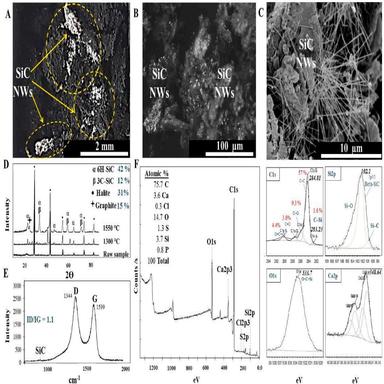
Structural and compositional characterization of Bio-C1550 bulk powder product displaying the macroscopic characteristics of the manufactured SiC NWs clusters and networks. A) Digital image of the 1D-SiC NWs clusters distributed on the biocarbon surface captured out of the reaction chamber while still in the crucible. B) SEM-BSE3D micrograph of the NWs bulk clusters captured from the Bio-C1550 ground powder. C) HM-SEM micrographs of the SiC NWs. D) X-Ray diffraction patterns indicating the evolution from th